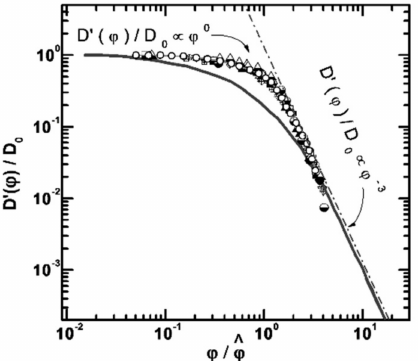
Figure 53. Generalized concentration dependence on concentration of the self-diffusion coefficients of globular proteins molecules [130]. The figure shows the experimental values for BSA (pH = 4.8–5.2), myoglobin (pH = 6.8–7.2), lysozyme (pH = 2.9–3.0 and pH = 7.4–7.8), barstar (pH = 8.0–8.2). The solid line is the generalized self-diffusion coefficients concentration dependence of the flexible ‐ chain polymers [132]. φ(cid:3549) –critical concentration, found as the intersection of the asymptote with zero slope ϕ − 3 , drawn to the experimental concentration dependences of the self ‐ diffusion coefficients of proteins.